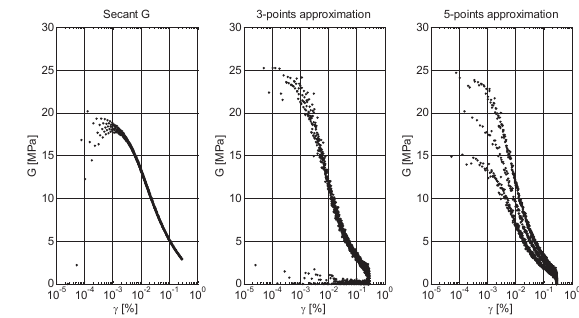
Figure 10: Results of TS analysis – sample Fig. 10. Results of TS analysis – sample S3057.